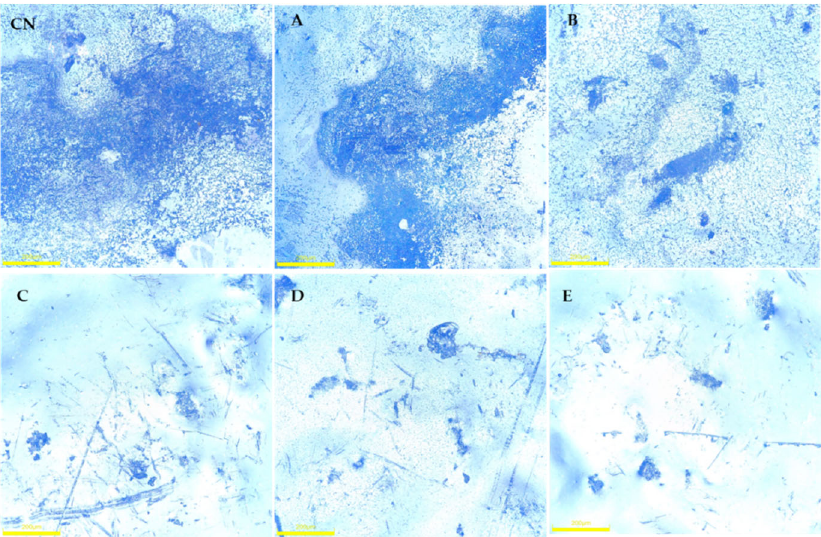
Figure 5. Images of ceramic tile surface with formed 24 h A. baumannii ATCC 19606 biofilm treated with different disinfection protocols ( A – E ). The control was provided with non ‐ treated biofilm ( CN ). Magnification 20×.